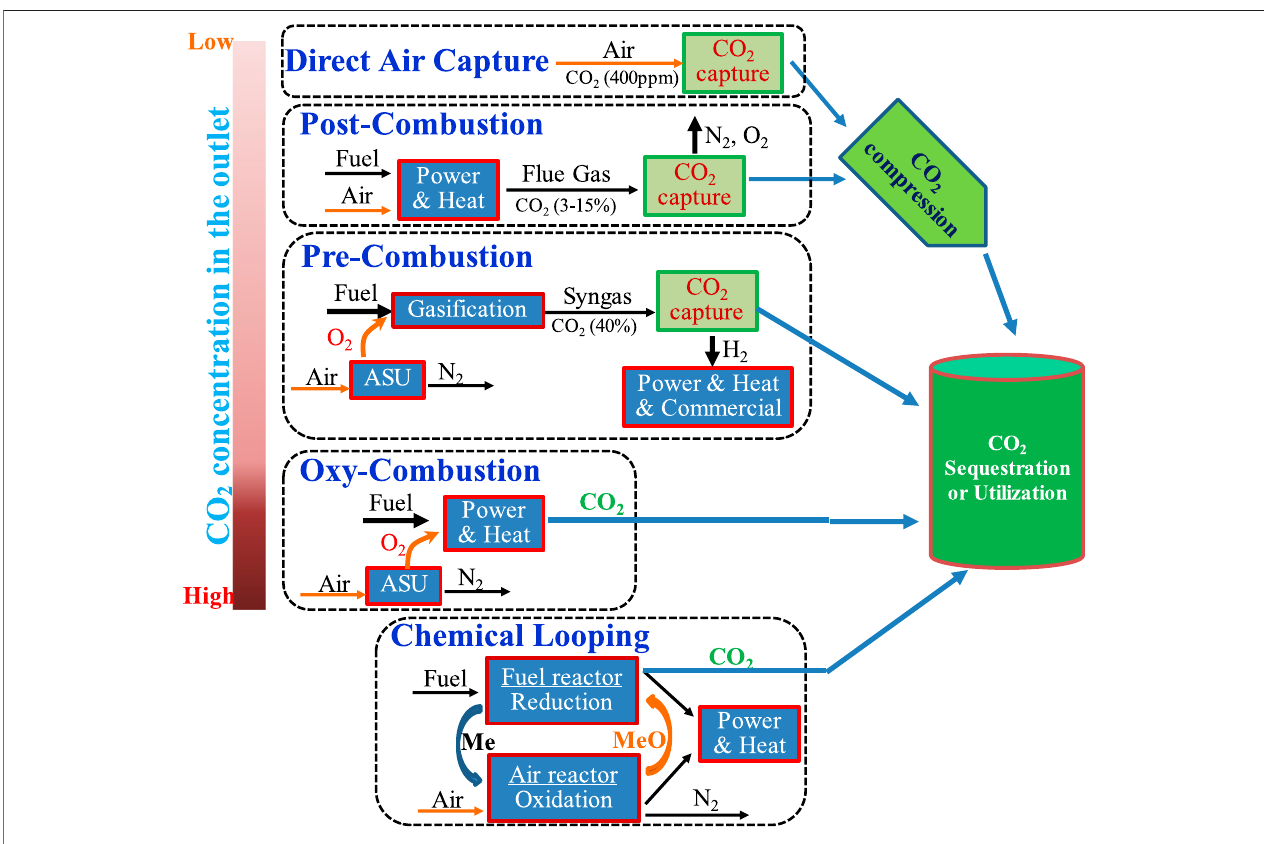
FIGURE 2 | Schematic diagram of the existing CO 2 capture